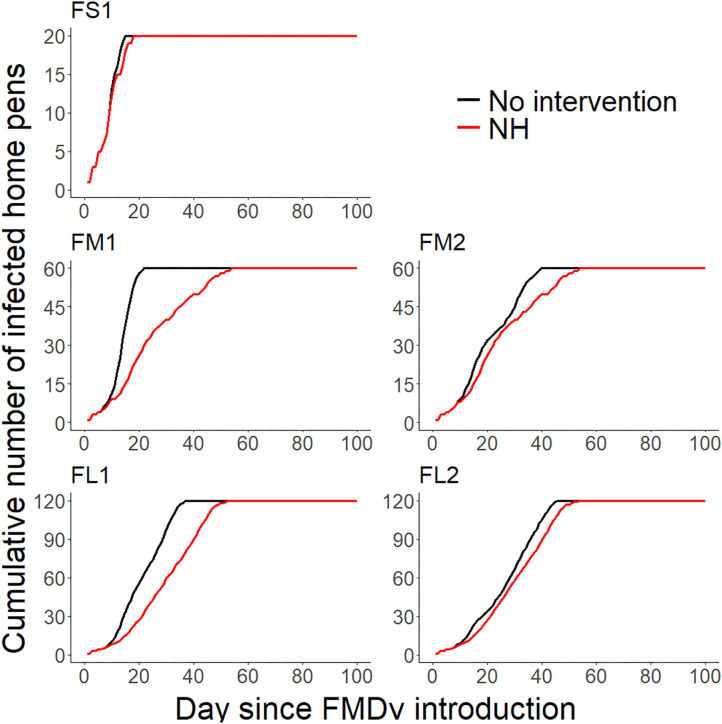
Line plots comparing the projected cumulative number of infected home-pens (Y-axis) during each day since FMDv introduction (X-axis) between the baseline no intervention scenario (28), and the hospital movement restriction (NH) scenario for each feedlot of size and layout. FS1—small-size feedlot with one hospital-pen, FM1—medium-size feedlot with one hospital-pen, FM2—medium-size feedlot with two hospital-pens, FL1—large-size feedlot with two hospital-pens; and FL2—large-size feedlot with four hospital-pens. The black solid lines represent the 50th percentile of the distribution of the projected cumulative number of infected home-pens across 2,000 simulated outbreaks for the baseline no intervention scenario for each feedlot size and layout (28), red solid lines represent the 50th percentile of the distribution of the projected cumulative number of infected home-pens across 2,000 simulated outbreaks for NH—hospital movement restrictions to stop mixing of cattle from different home-pens in the hospital-pen(s) after the day of FMD detection.